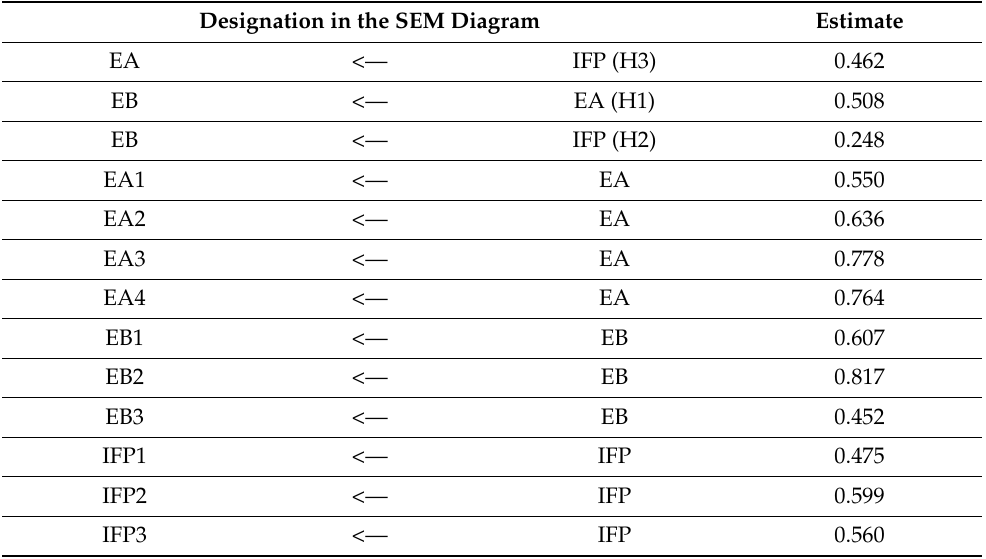
Table 4. Regression weights in the model (standardized